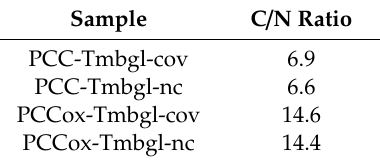
Table 3. The C / N ratio of PCC-Tmbgl-cov, PCC-Tmbgl-nc, PCCox-Tmbgl-cov, and